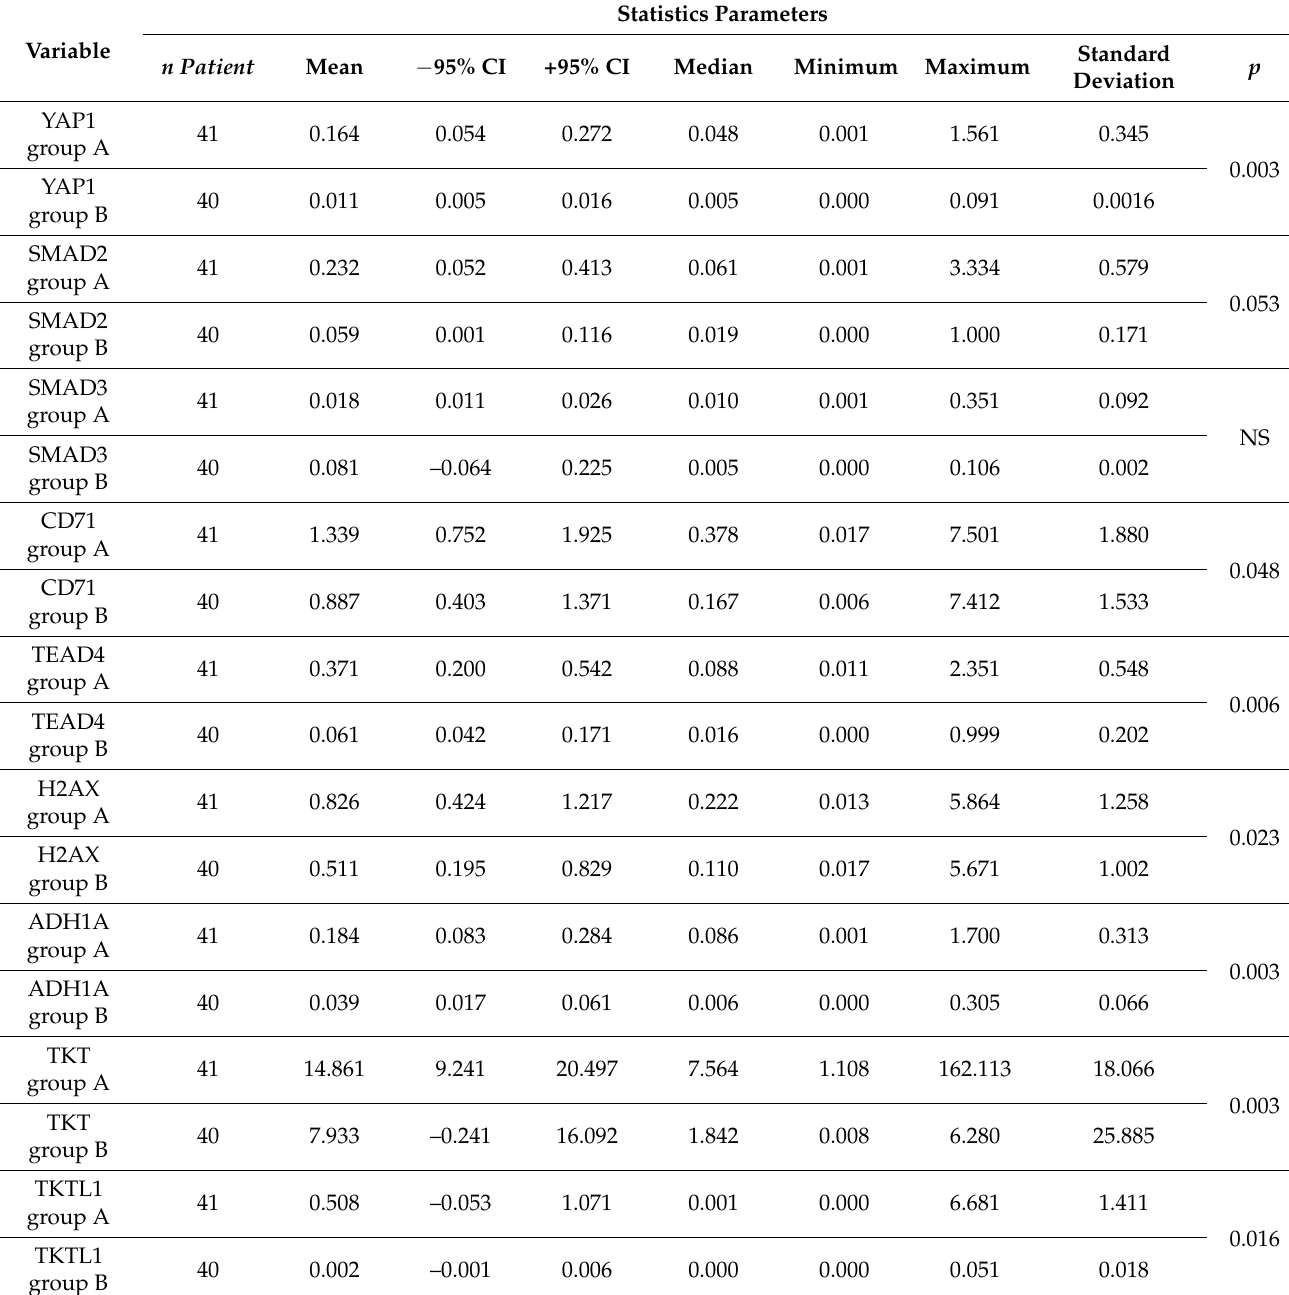
Table 3. Statistic parameters; group A: cancer and group B: